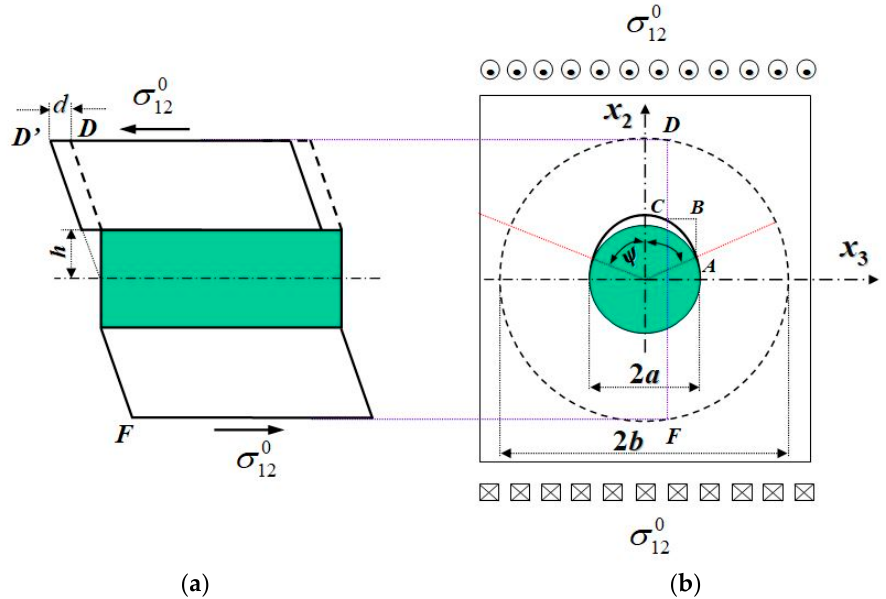
Figure 7. Schematic diagram for relative slippage of a RVE subjected to an in-plane shear shown in ( a ) a longitudinal cross-section, ( b ) a transverse cross-section.